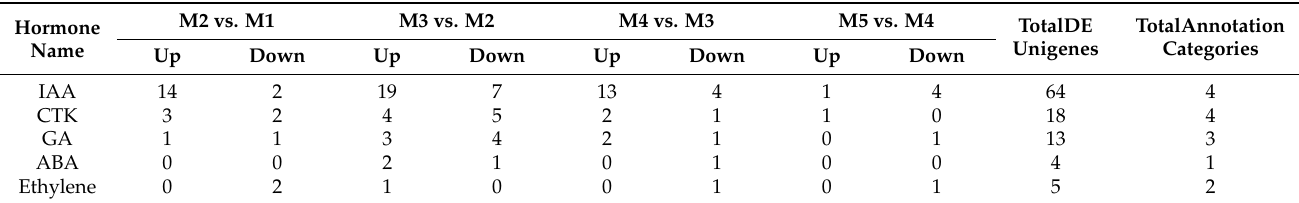
Table 2. Differentially expressed D. pectinatum unigenes involved in hormone signal transduction pathway among male cone samples.